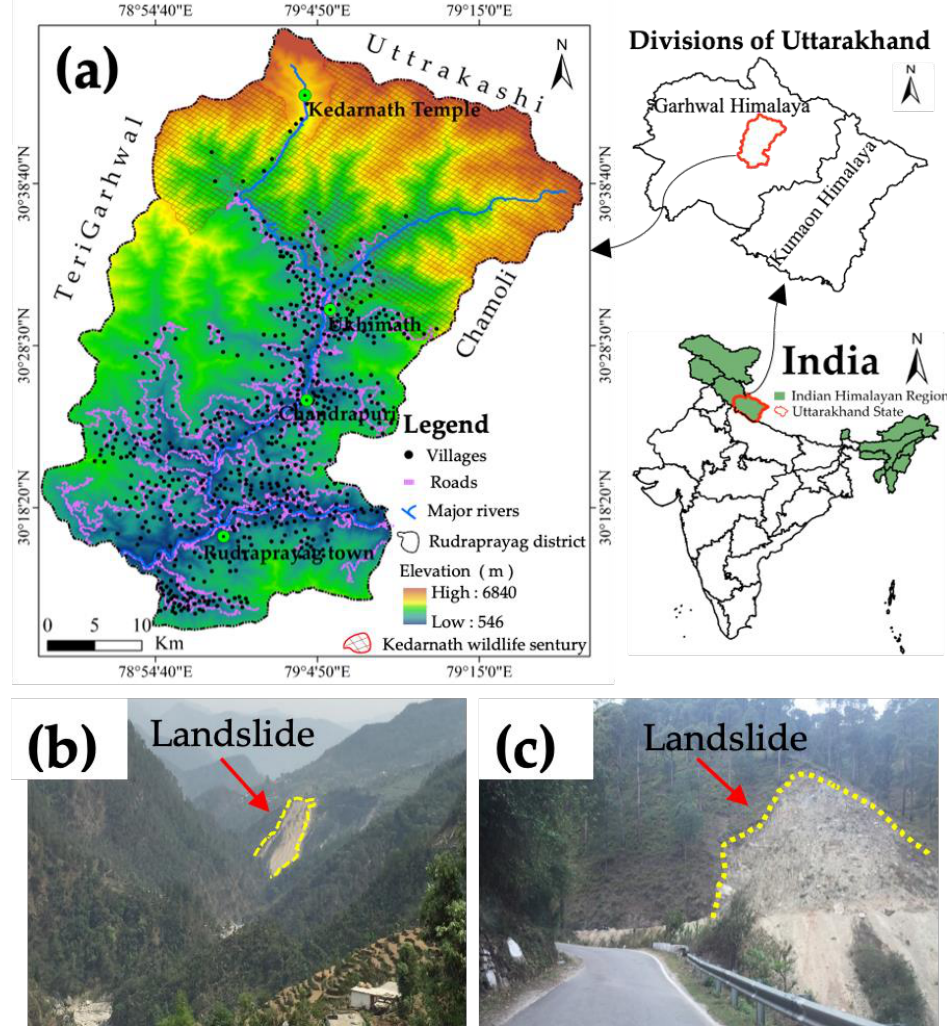
Figure 1. The study area ( a ) location map of Rudraprayag district of Uttarakhand state in the Indian Himalayan Region; and field photographs of landslide occurrences (2016/04/03) in the study area; ( b ) tree lost by landslide; and ( c ) road damaged by landslide.